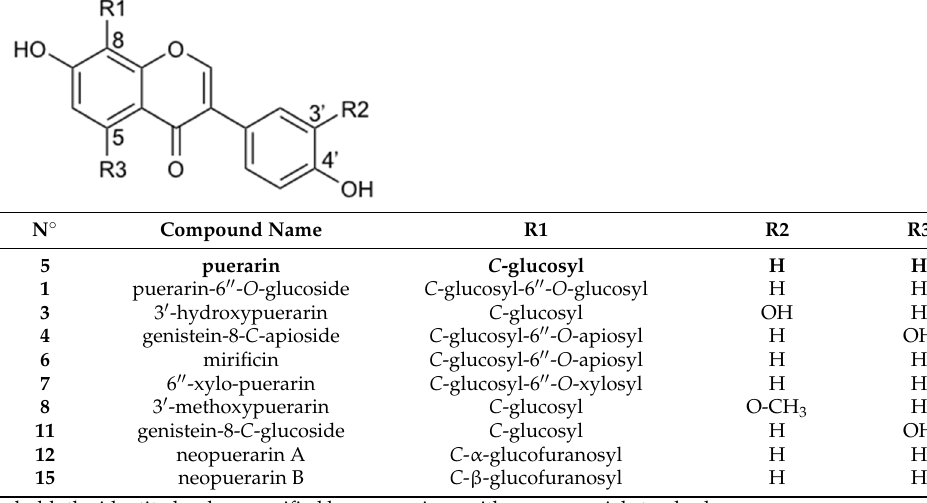
Table 3. Structures of annotated isoflavone C -glycosides.